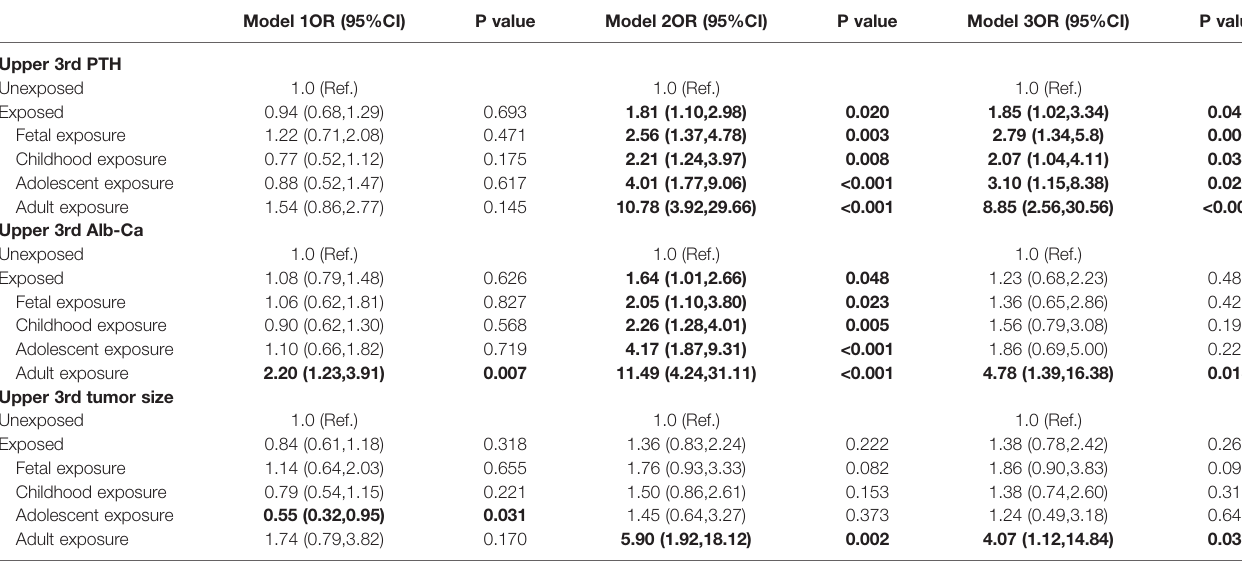
TABLE 4 | ORs (95%CIs) for upper 3 rd serum PTH, albumin-corrected calcium levels and tumor size in PHPT patients with famine exposure at different stages of